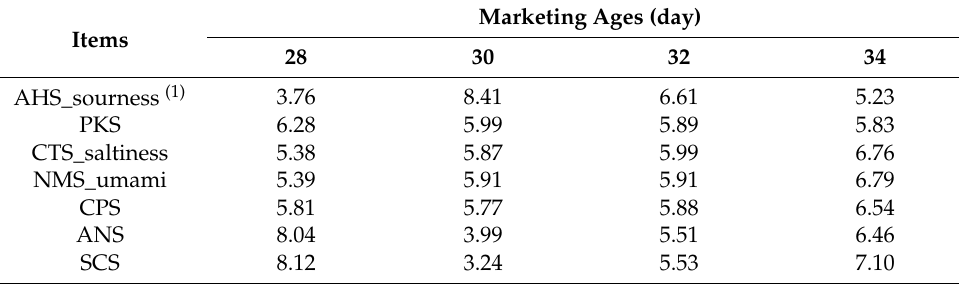
Data are shown as means. (1) Indicated the 7-sensor array of the electronic